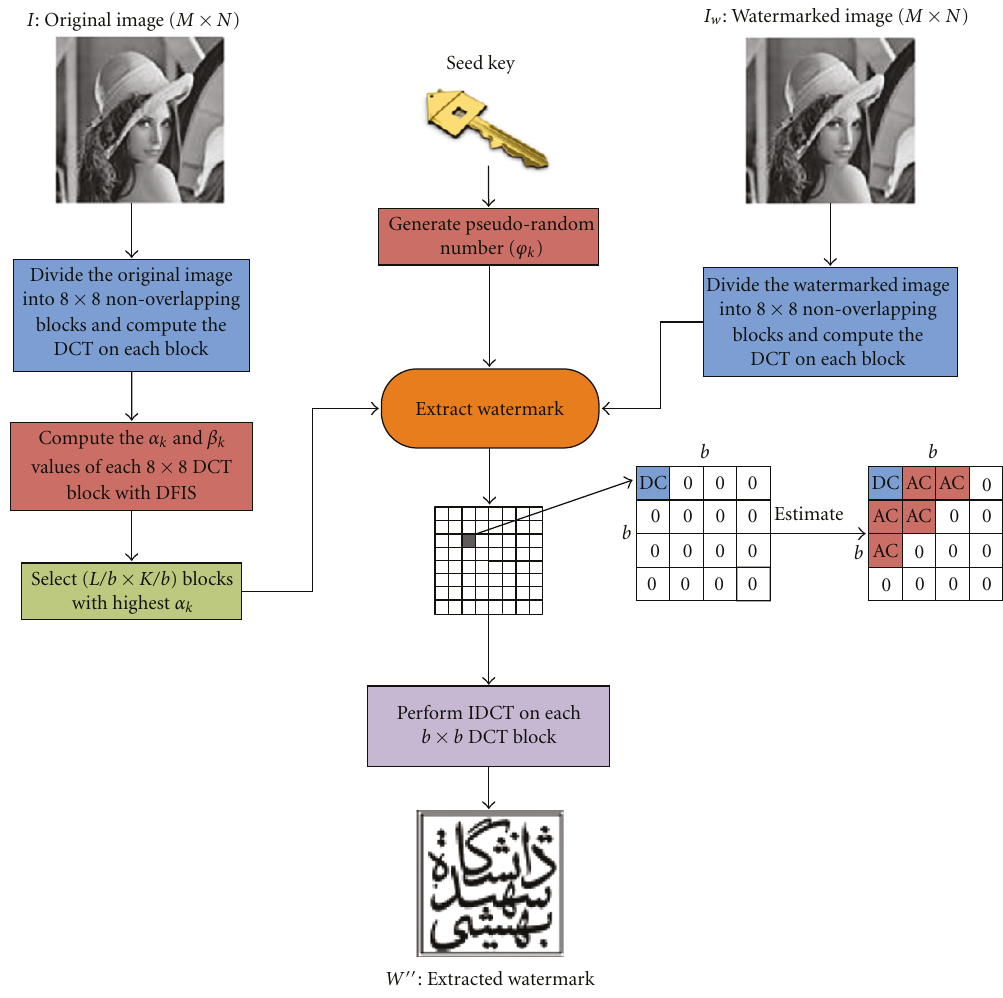
Figure 9: Proposed watermark extraction process.